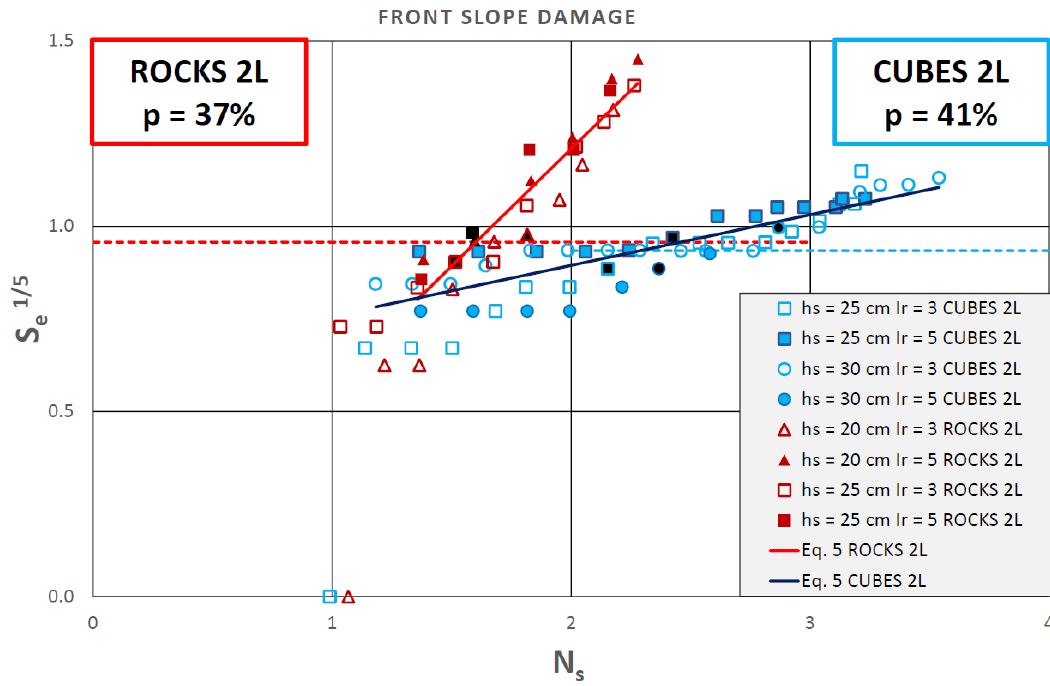
Figure 6. Measured armor damage, S e , to the front slope as a function of the stability number (rock and cube armors).